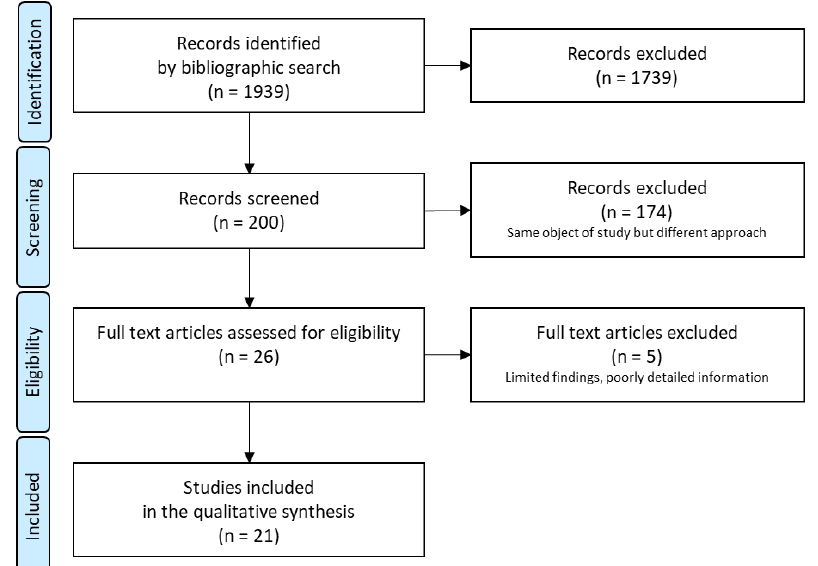
Figure 1. Flow diagram of analysis process.